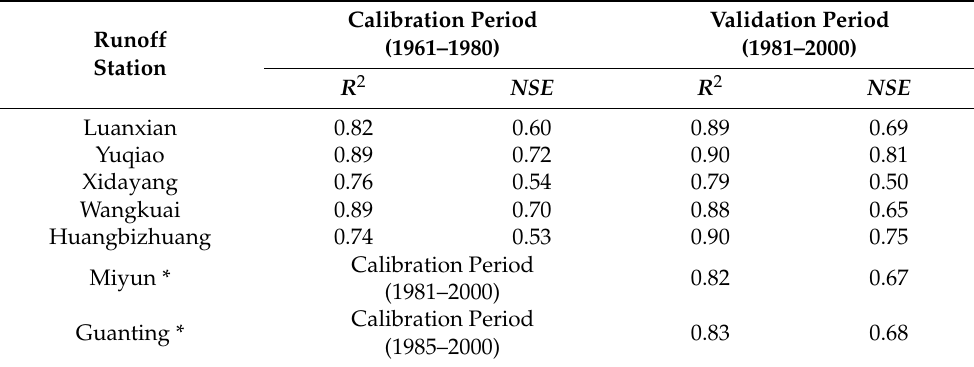
Table 2. Calibration and validation results of cross-section runoff in the study